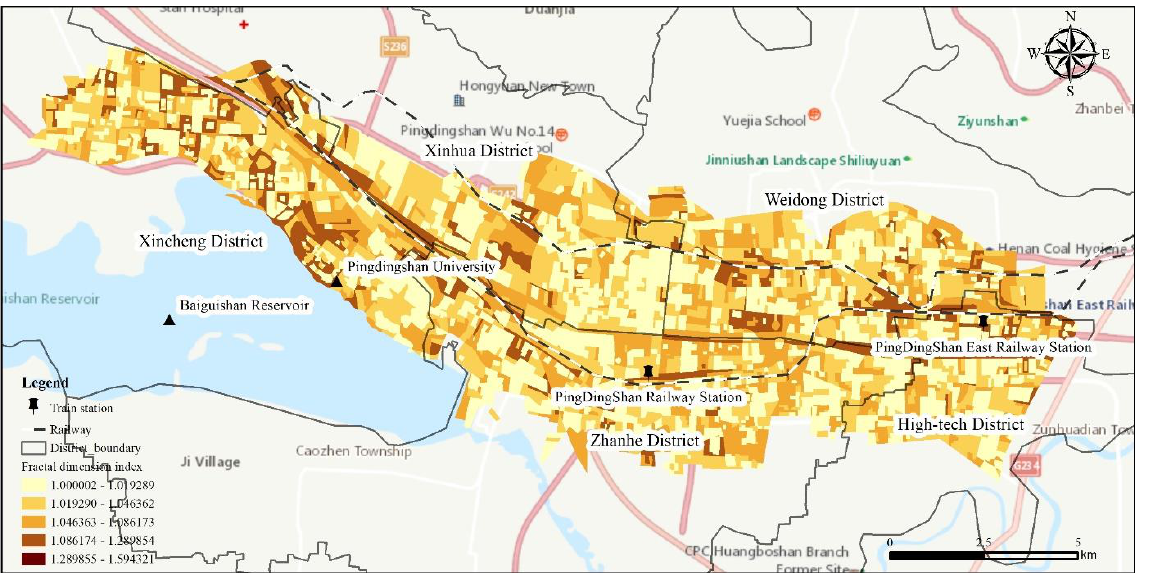
Figure 2. Fractal dimension index spatial visualization of road enclosure patches in Pingdingshan city.